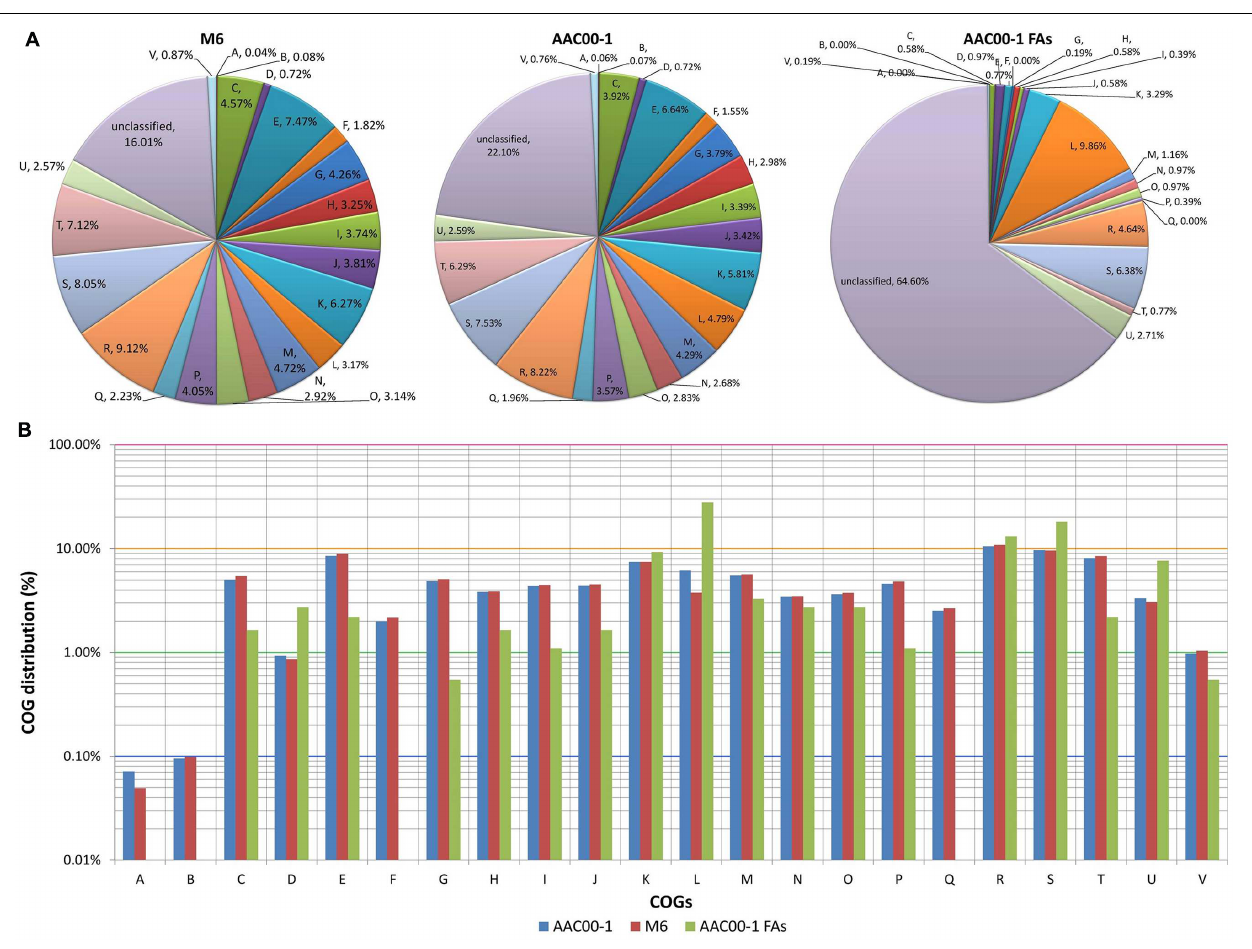
FIGURE 5 | COG distribution in Acidovorax citrulli M6, AAC00-1 and AAC00-1 FA fragments. (A) Pie plot illustrating COG distribution of predicted ORFs from M6 and AAC00-1 genomes as well as from the eight AAC00-1 FA fragments. ORFs that could not be classified into any category are grouped as “unclassified.” (B) Column plot representation of COG distribution. The unclassified ORFs were excluded from this analysis. COG functional categories: (A) RNA processing and modification; (B) chromatin structure and dynamics; (C) energy production and conversion; (D) cell cycle control, cell division and chromosome partitioning; (E) amino acid transport and metabolism; (F) nucleotide transport and metabolism; (G) carbohydrate transport and metabolism; (H) coenzyme transport and metabolism; (I) lipid transport and metabolism; (J) translation, ribosomal structure and biogenesis; (K) transcription; (L) replication, recombination and repair; (M) cell wall/membrane/envelope biogenesis; (N) cell motility; (O) post-translational modification, protein turnover, chaperones; (P) inorganic ion transport and metabolism; (Q) secondary metabolites biosynthesis, transport and catabolism; (R) general functional prediction only; (S) function unknown; (T) signal transduction mechanisms; (U) intracellular trafficking, secretion, and vesicular transport; and (V) defense